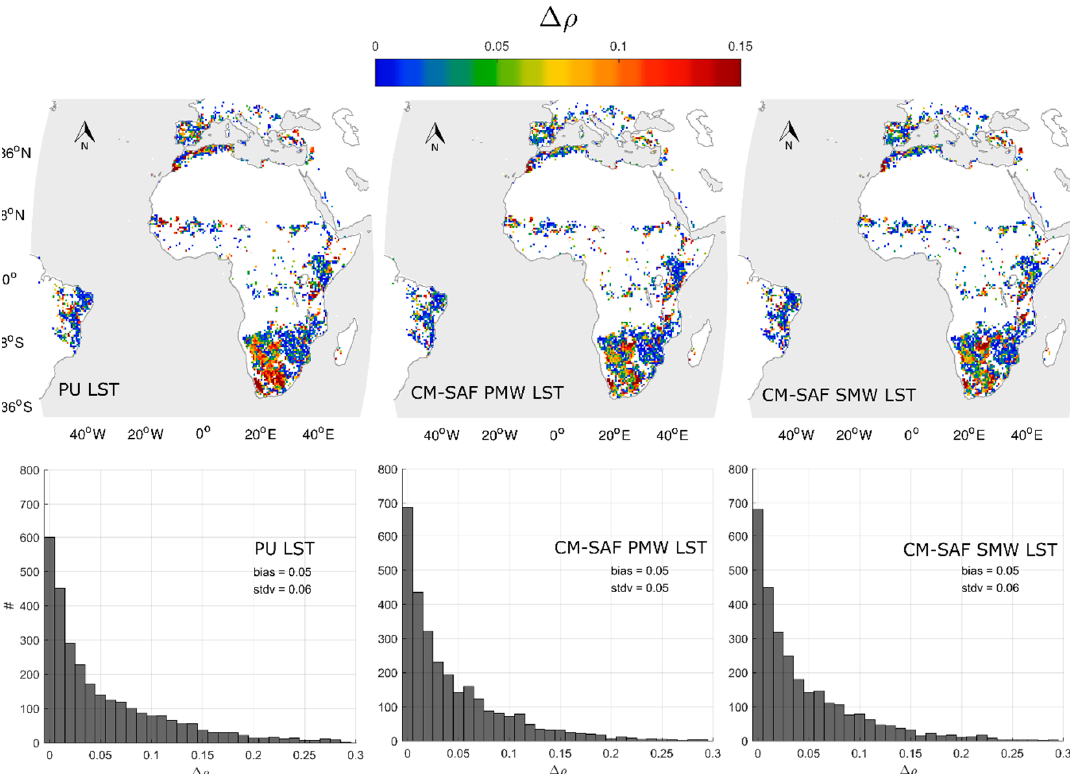
Figure 3. Maps ( top ) and histograms ( bottom ) showing the increase in VHI-SPEI correlations, when α is changed from 0.5 to the optimum values estimated with the iterative procedure: VHI estimated with TCI derived from PU LST ( left ), CM-SAF PMW LST ( middle ), and CM-SAF SMW LST ( right ).